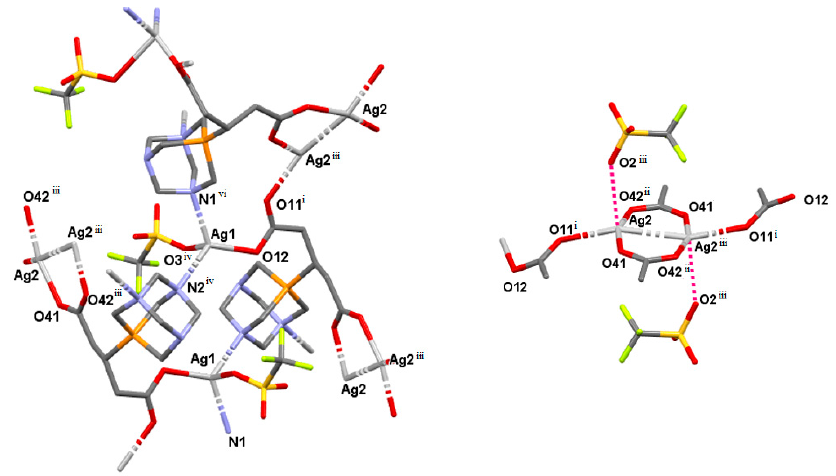
Figure 8. Partial packing view of CP1.2 with selected bond lengths ( left ). Geometry of Ag2…Ag2 junctions ( right ). Hydrogen atoms are omitted for the clarity. (Bond lengths (Å): Ag1–O12 = 2.282(3),